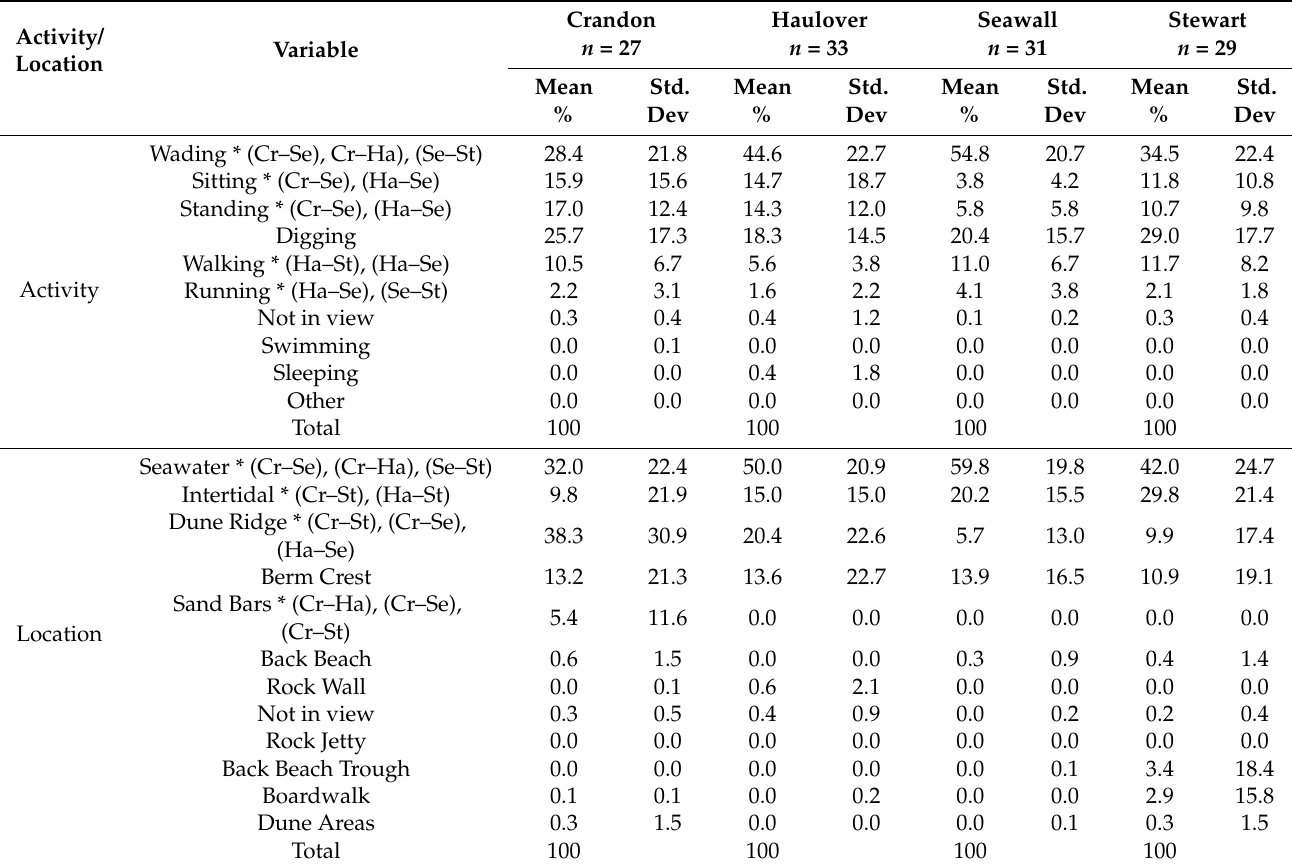
Table 5. Mean Percent Time Spent Engaged in Various Activities and Locations by Beach Activity/